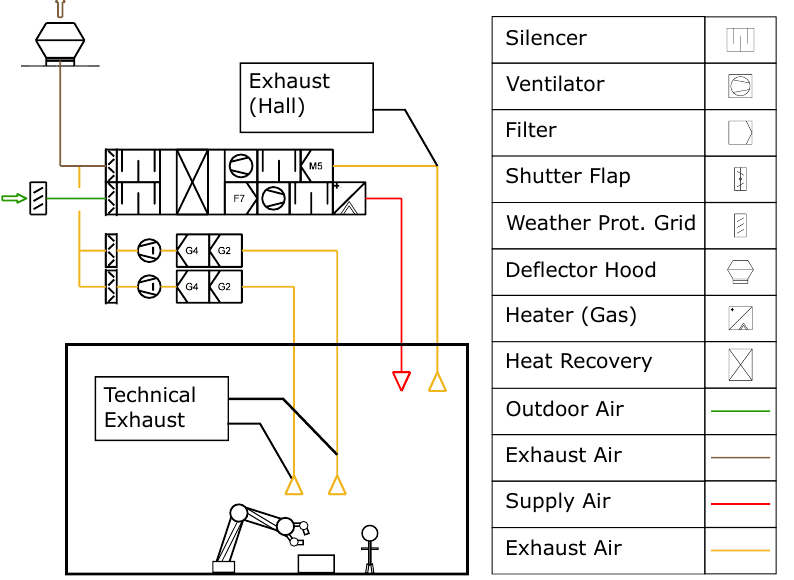
Figure 2. Schematic representation of the HVAC system and the difference between the two